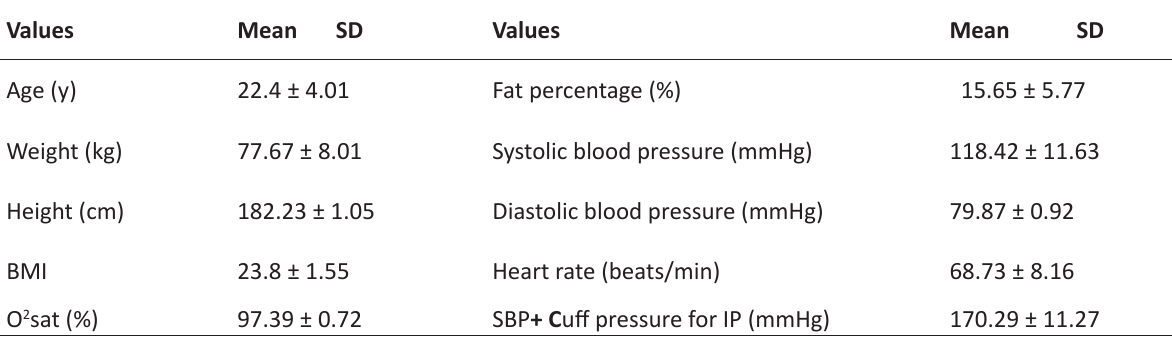
Table 1 . Subject characteristics and resting blood pressure.